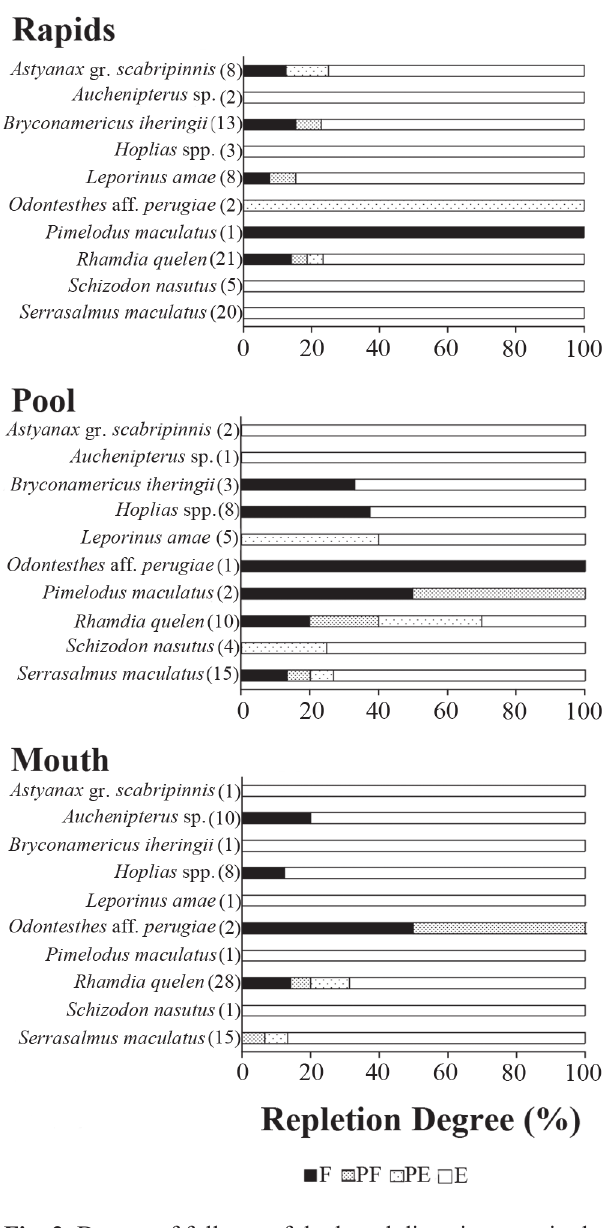
Fig. 2. Degree of fullness of the larval digestive tract in the samples obtained from three locations of the Ligeiro River, during the months of September 2006 through March 2007 (the number of larvae analyzed is shown in parenthesis). F = Full, PF = Partially Full; PE = Partially Empty, E